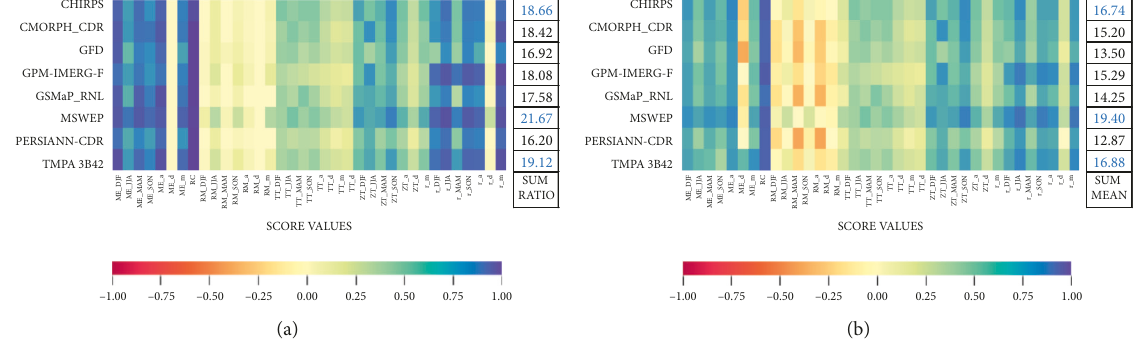
Figure 3: Heatmaps of time sequence performance metrics by ratio (a) and mean (b) with corresponding